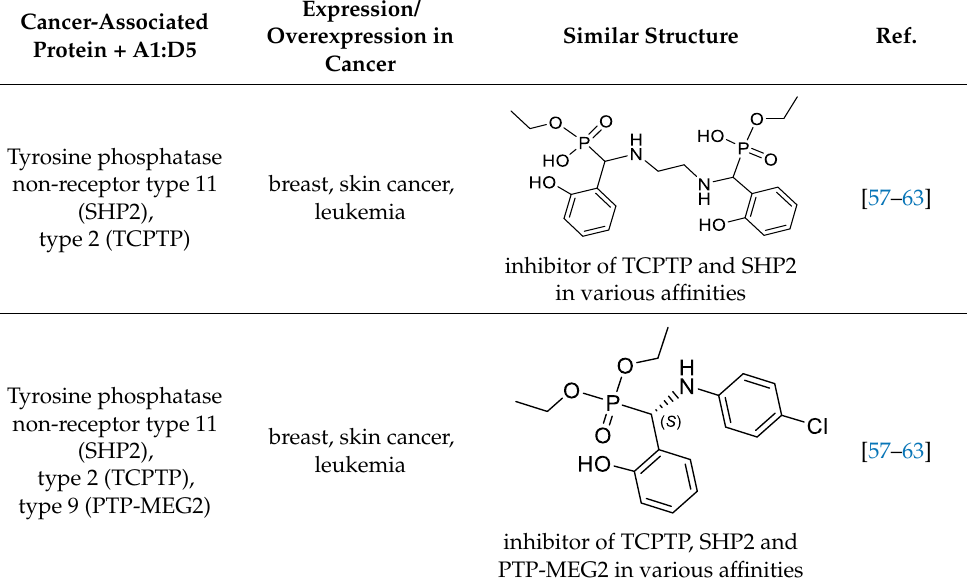
Table 5. Cont. Cancer-Associated Protein + A1:D5